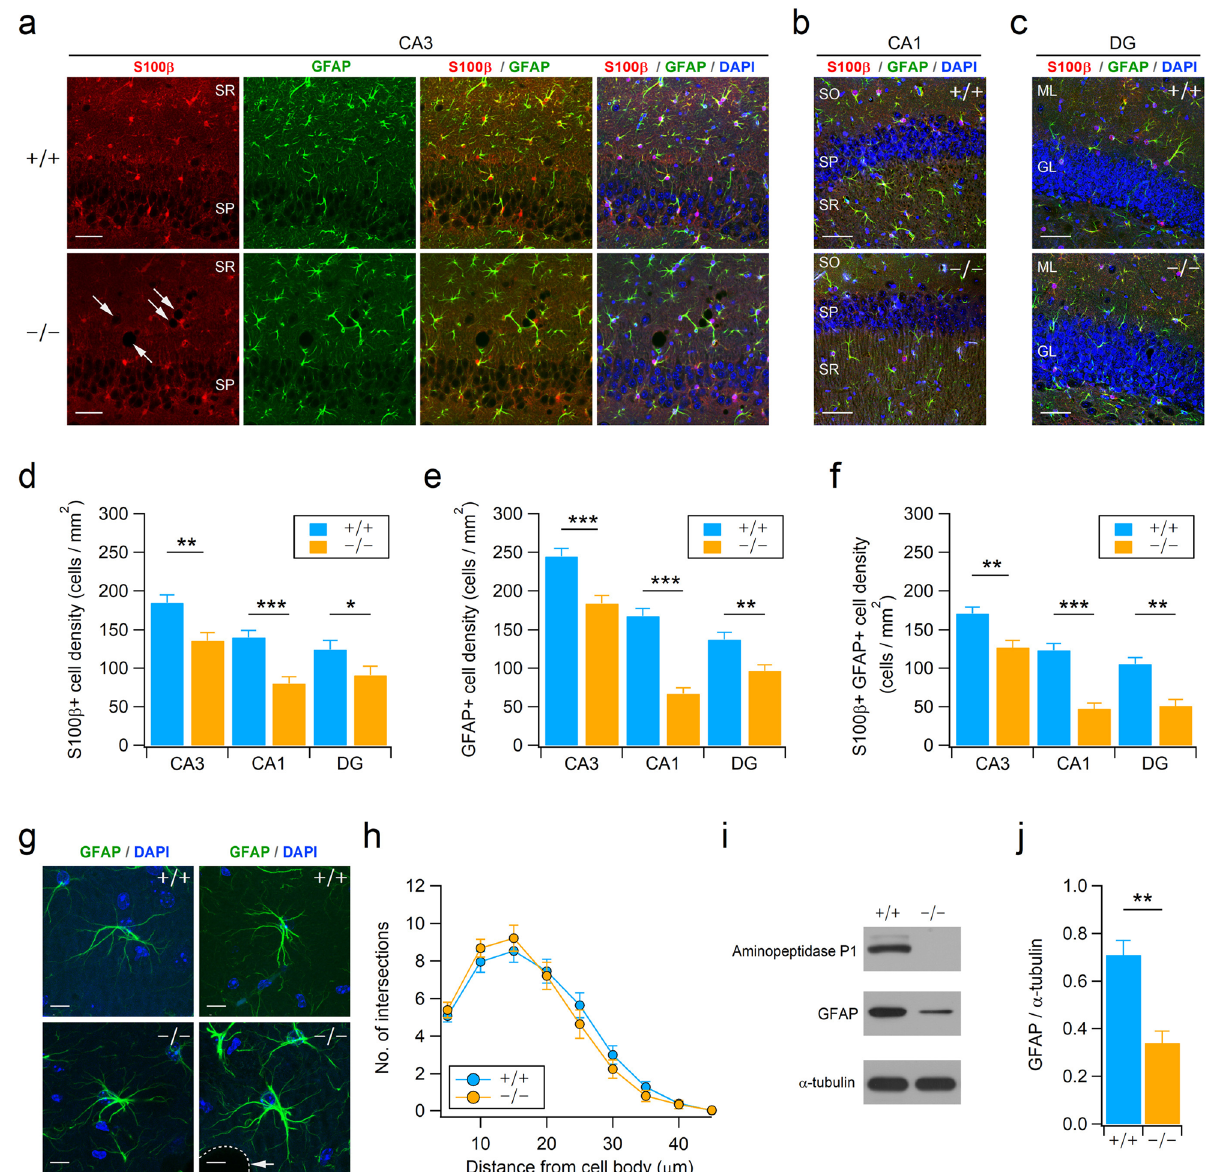
Figure 5. Reduction of astrocytes in the Xpnpep1 −/− hippocampus. ( a ) Astrocytes in the hippocampal CA3 regions from 4- to 5-week-old WT (top) and Xpnpep1 −/− (bottom) mice were stained with GFAP and S100β antibodies. DAPI was used to visualize cell nuclei, and arrows indicate vacuoles. Immunofluorescence images of hippocampal CA3 regions show fewer astrocytes in Xpnpep1 −/− mice than in WT mice. ( b , c ) Astrocytes in the CA1 ( b ) and DG ( c ) subfields of Xpnpep1 +/+ (top) and Xpnpep1 −/− (bottom) mice are visualized. Scale bars, 50 µm ( a – c ). SP, stratum pyramidale ; SR, stratum radiatum ; SO, stratum oriens ; ML, molecular layer; GL, granule cell layer. ( d – f ) The density of GFAP- and S100β-positive cells in the CA3, CA1, and DG regions were lower in Xpnpep1 −/− mice than in WT mice. * p < 0.05; ** p < 0.01; *** p < 0.001 by Student’s t -test, n = 6 slices from 3 mice for each genotype. ( g ) The morphology of astrocytes and cell nuclei in the hippocampal CA3 subfield were visualized by GFAP (green) and DAPI (blue), respectively. The morphological features of reactive astrocytes, such as hypertrophy and extension of processes, were not detected in Xpnpep1 −/− astrocytes. Arrow indicates vacuole. Scale bars, 10 µm. ( h ) Sholl analysis of astrocyte complexity in the hippocampal CA3 subfield. n = 28 cells from 3 mice per genotype. p > 0.05 by Student’s t -test and Mann–Whitney test. ( i ) Representative western blots showing the expression levels of aminopeptidase P1 and GFAP in the hippocampal extracts. Western blotting using anti-α-tubulin antibody was performed to ensure equal protein loading and transfer, and quantification of protein levels in each sample. ( j ) Quantification of GFAP protein levels (right) in the Xpnpep1 +/+ (n = 4) and Xpnpep1 −/− (n = 4) hippocampus. t (6) = 4.62, ** p = 0.0036 by Student’s t